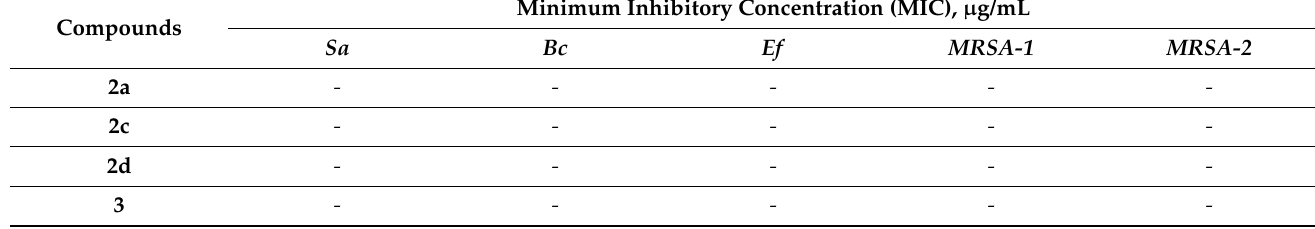
Table 2. Antimicrobial activity of studied